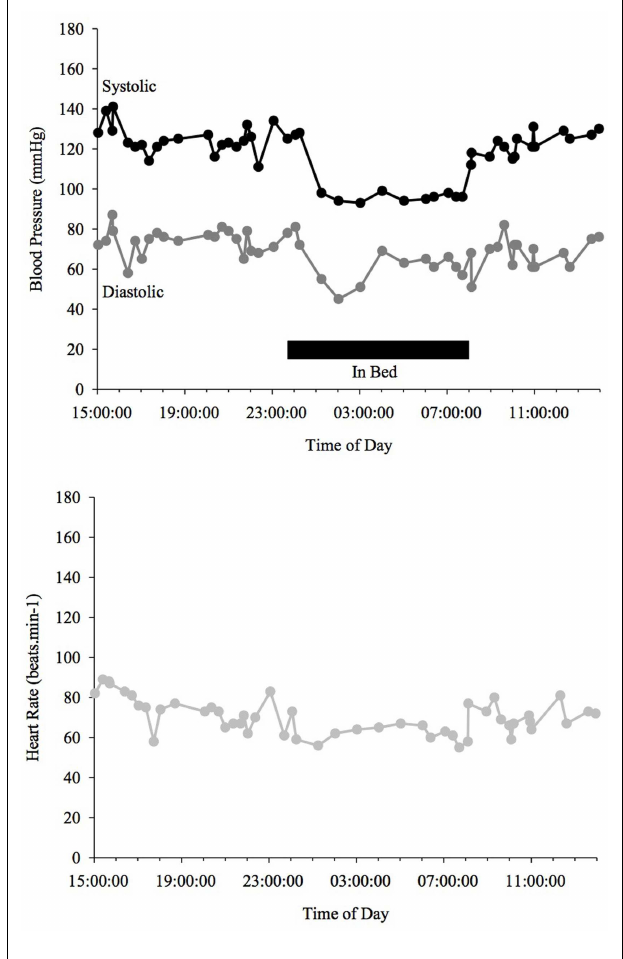
FIGURE 1 | Blood Pressure (upper line systolic, lower line diastolic) and heart rate profiles during 24hABPM of a healthy individual; dipper, showing more than a 10% drop in BP at night time. Black bar indicates